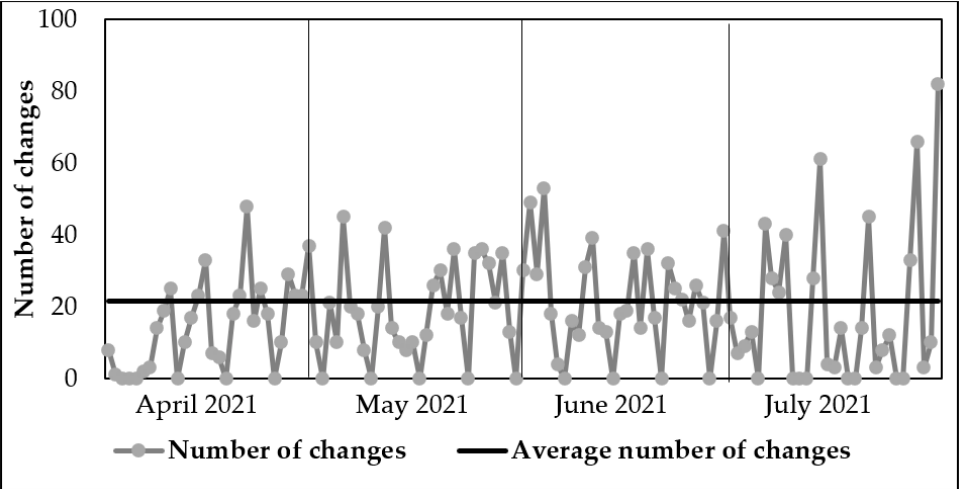
Figure 8. Changes implemented in the optimal variant.